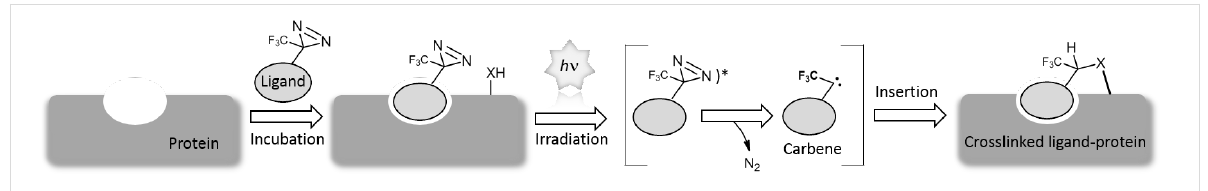
Figure 1: Principle of photoaffinity labeling of proteins with diazirine derivatives. Photolabile ligands are complexed with the receptor protein and the following photochemical excitation of the complex leads to formation of a reactive carbene after extrusion of nitrogen and a crosslinked product after insertion reaction; X = e.g., NH, O, CH 2